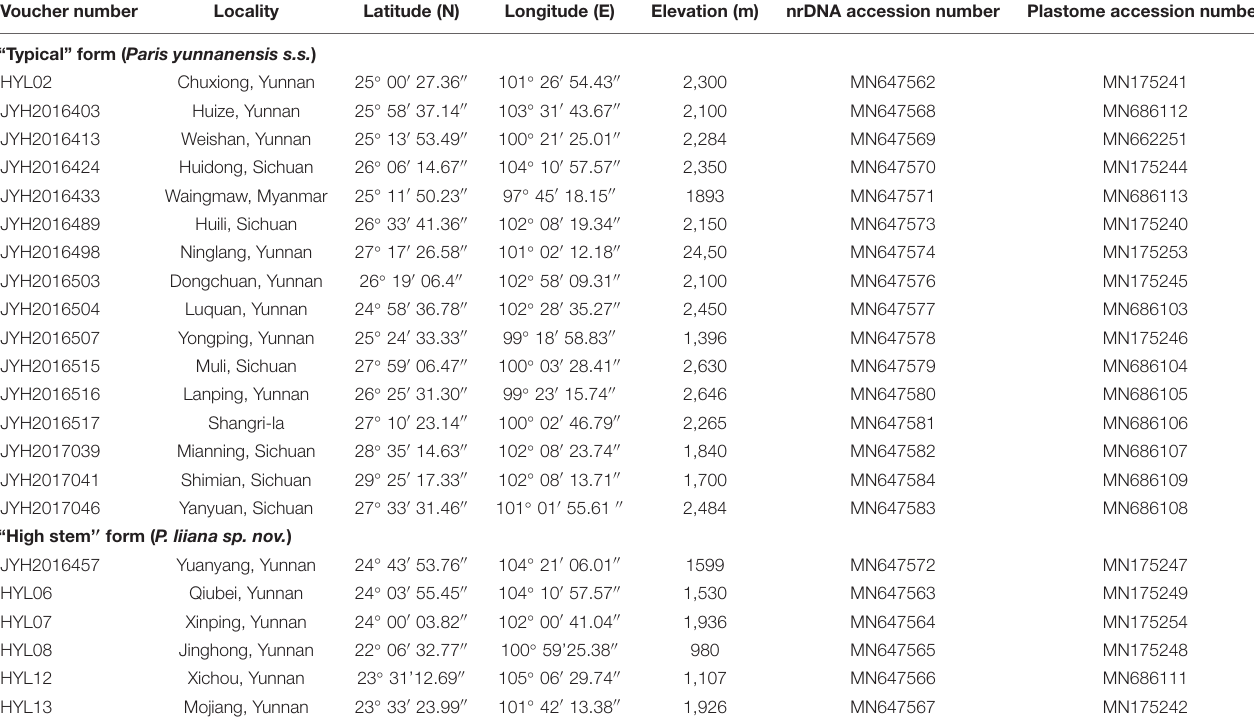
TABLE 1 | Voucher information and GenBank accessions for the 22 Paris yunnanensis